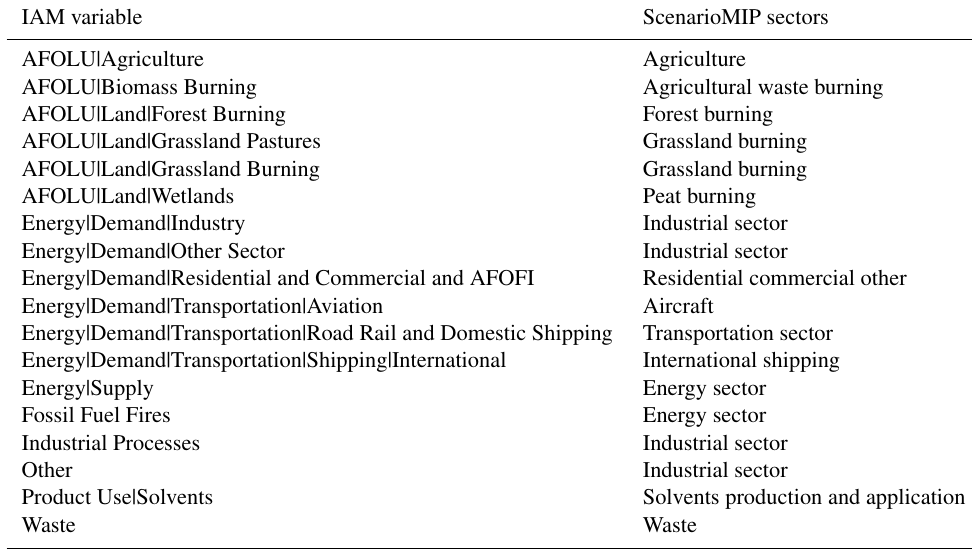
Table B2. The sectoral mapping used to aggregate model output data to a common sectoral definition.